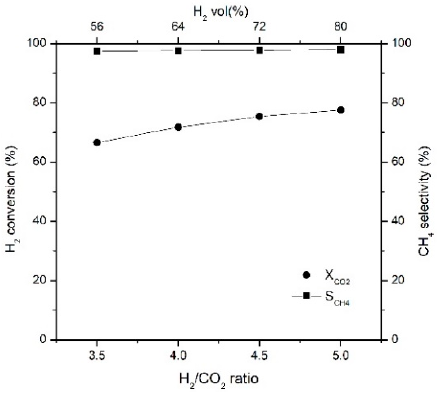
Figure 5. Effect of H 2 /CO 2 ratio on CO 2 conversion and CH 4 selectivity .